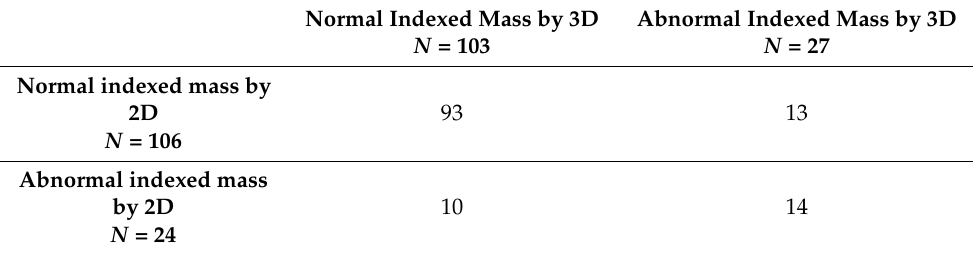
Table 3. Number of normal and abnormal indexed lass values measured by 2D and 3D.